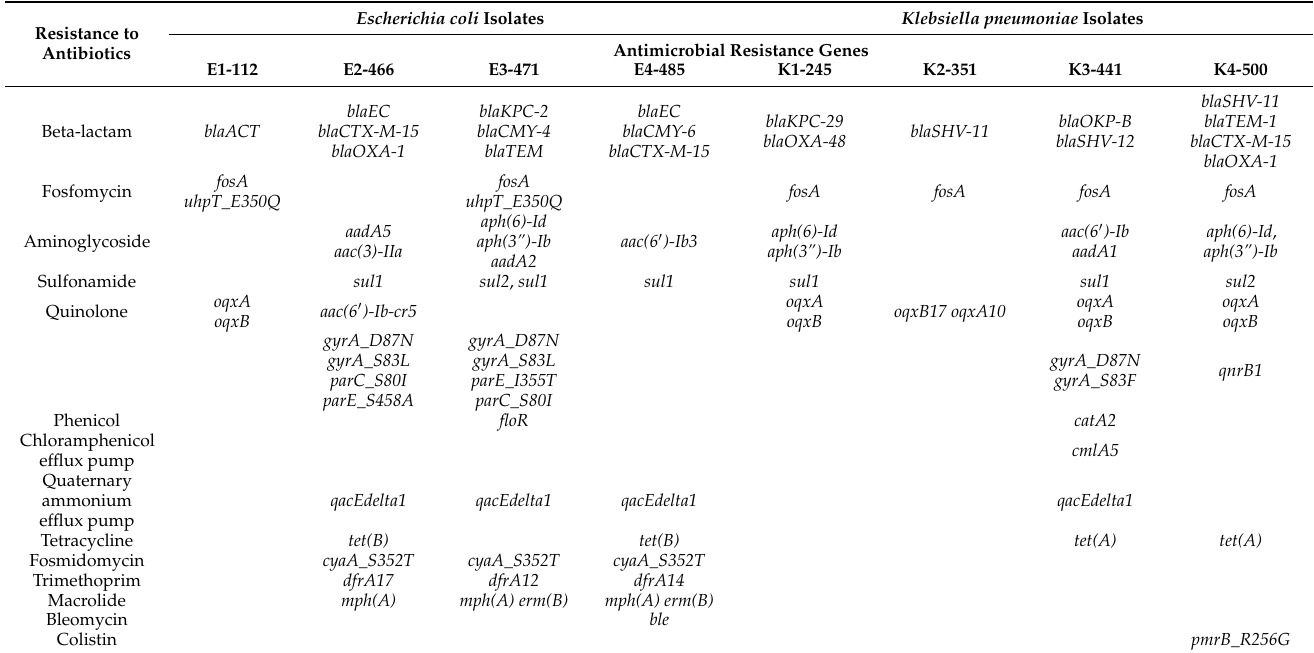
Table 5. Types of resistance genes and mechanisms of Escherichia coli and Klebsiella pneumoniae isolates to different antimicrobial agents detected by